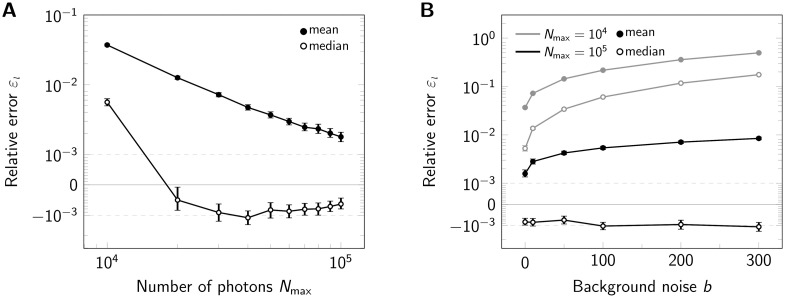
Influence of signal brightness and noise.Relative error εl for estimation of tetramer side length upon variation of the maximum photon number Nmax (A) and background noise (B) shown in a symmetric logarithmic plot. For each data point 500000 tetramers (side length 5 nm) were simulated. In both panels we compared the analysis via the mean (full symbols) and median (open symbols). Positive and negative relative errors represent overestimation and underestimation, respectively. In panel A we assumed zero background noise b, in panel B we considered Nmax = 104 photons (gray lines) and Nmax = 105 (black lines). Error bars indicate the 95% confidence intervals.